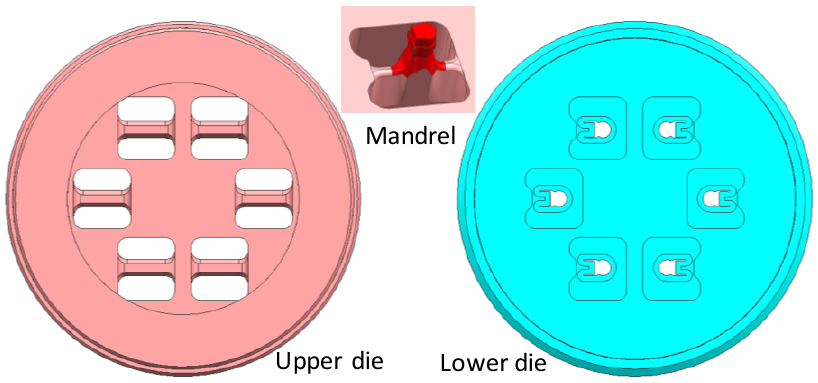
Figure 5. The traditional tool design in terms of the selected multi-porthole extrusion process.